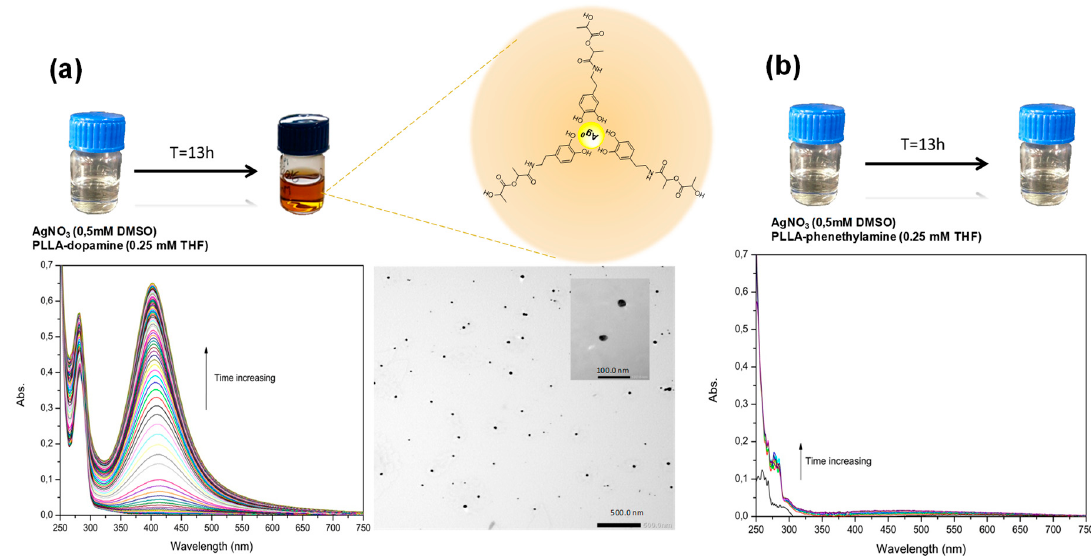
Figure 5. ( a ) The progress of the Ag + reduction in the presence of catechol-PLLA studied